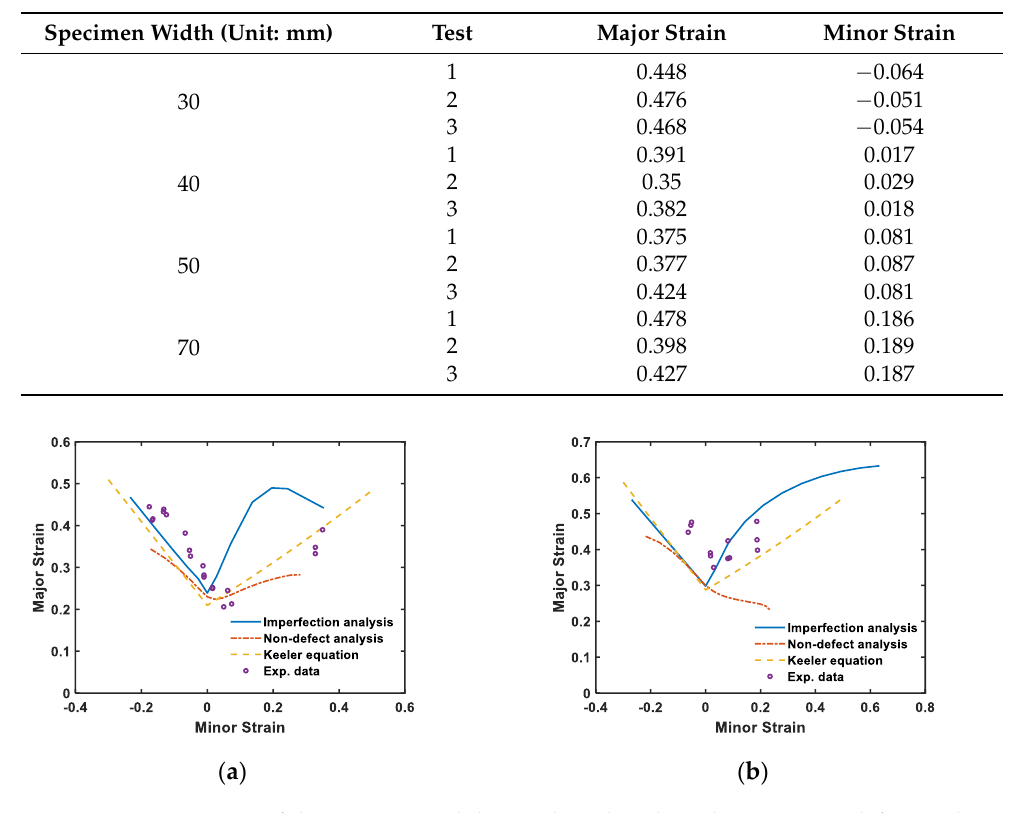
Figure 16. Comparison of the experimental data and predicted results using non-defect analysis, imperfection analysis, and Keeler’s equation: ( a ) high-strength steel; ( b ) low-carbon steel.